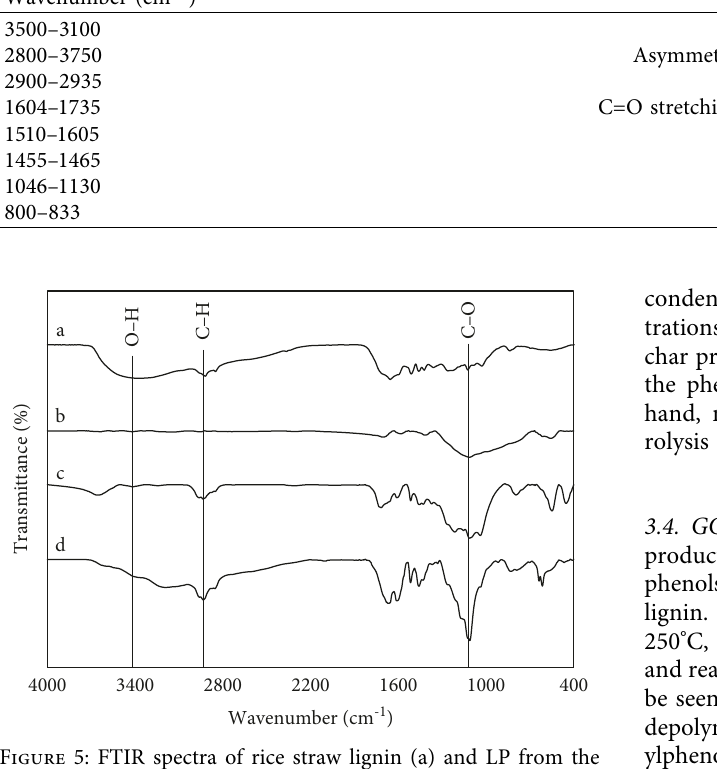
Figure 4: FTIR spectra of rice straw lignin (a) and char/or solid residue from the lignin depolymerization under the ethanol concentration of (b) water, (c) 50%, and (d) 100% at 275 ° C, 30 min, 75:1 (mL ethanol: 1g Table 2: FTIR wavenumber and functional groups are present in the rice straw lignin and its depolymerization products. Wavenumber (cm − 1 )